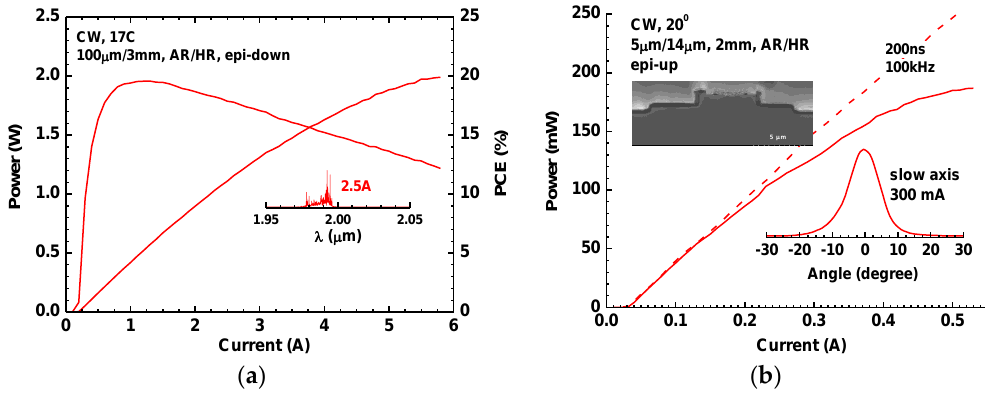
Figure 5. ( a ) CW light-current-power conversion characteristics measured at 17 °C for 100-μm-wide, 3-mm-long anti-/high-reflection (AR/HR) coated two-stage cascade lasers [16]. Insert shows the device’s emission spectra. ( b ) Pulsed (200 ns/100 kHz) and CW light-current characteristics measured at 20 °C for 5-μm-/14-μm-wide double-step, 2-mm-long, AR/HR coated two-stage cascade lasers mounted epi-side-up. Inserts show the scanning electron microscope (SEM) image of laser facet and measured slow axis far-field pattern.